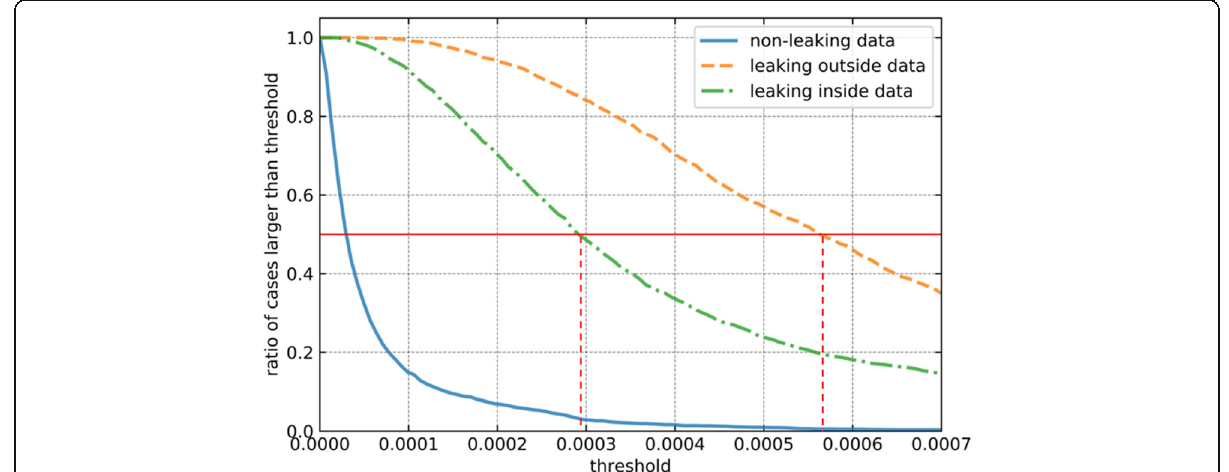
Fig. 15 Percent of leak warning at different detection thresholds of AE model under different pipe